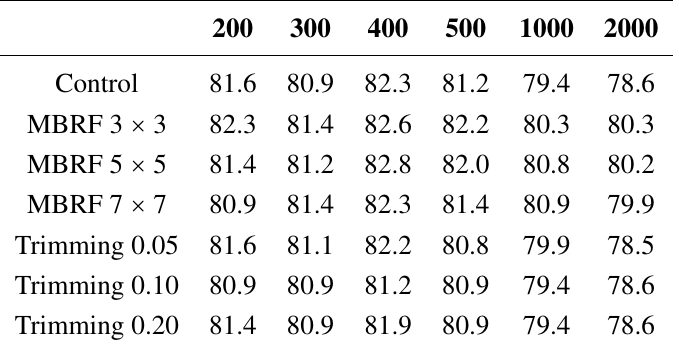
Table 3. Adjusted accuracy values ( n = 657 ) for the Eurasian region according to the automated sample selection